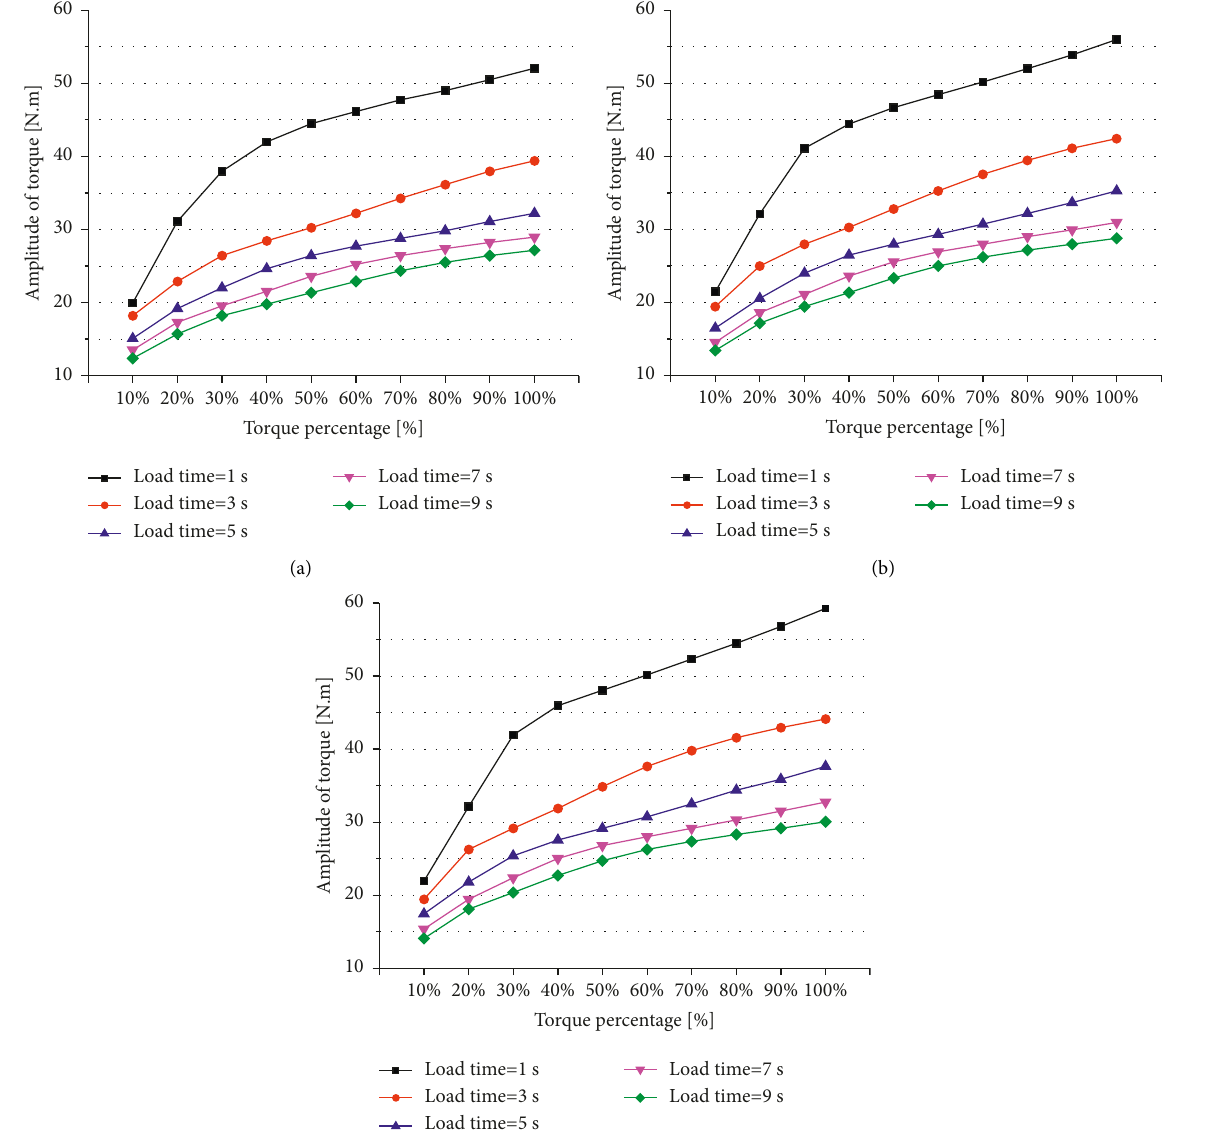
Figure 15: Calculated torque response amplitudes for different engaging parameter values: (a) N